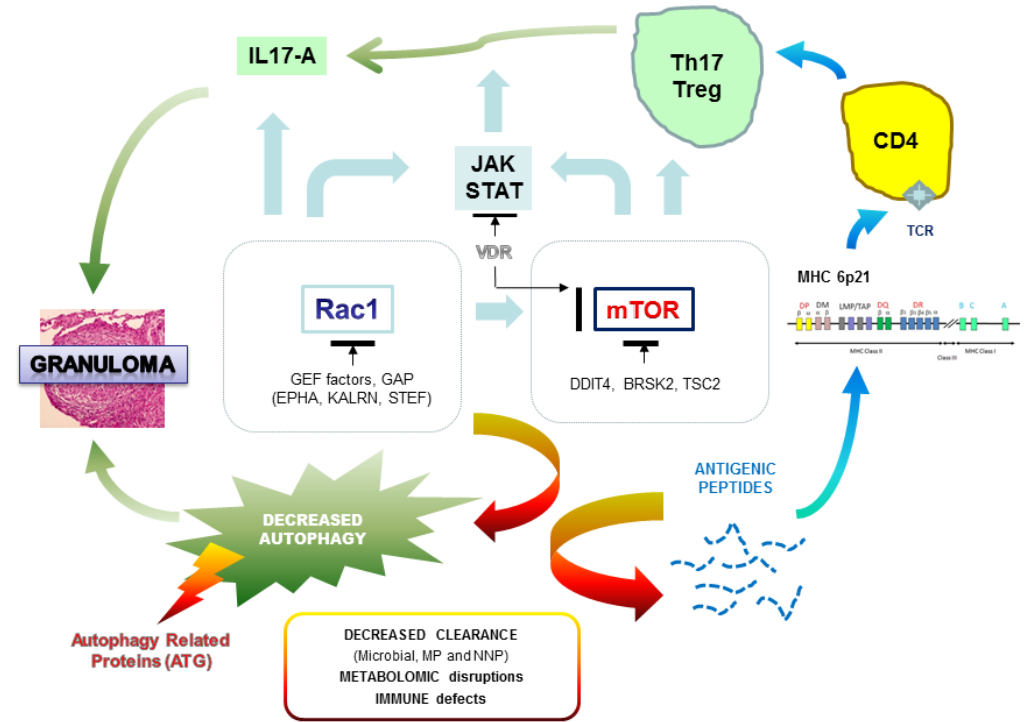
Figure 2. Functional hypothesis in the genesis of granuloma and relationship with deregulation of autophagy. MHC designates the major histocompatibility complex, VDR is the vitamin D receptor, and TCR is the T cell receptor. The black lines indicate a negative regulation. All the names of genes are detailed in the text.